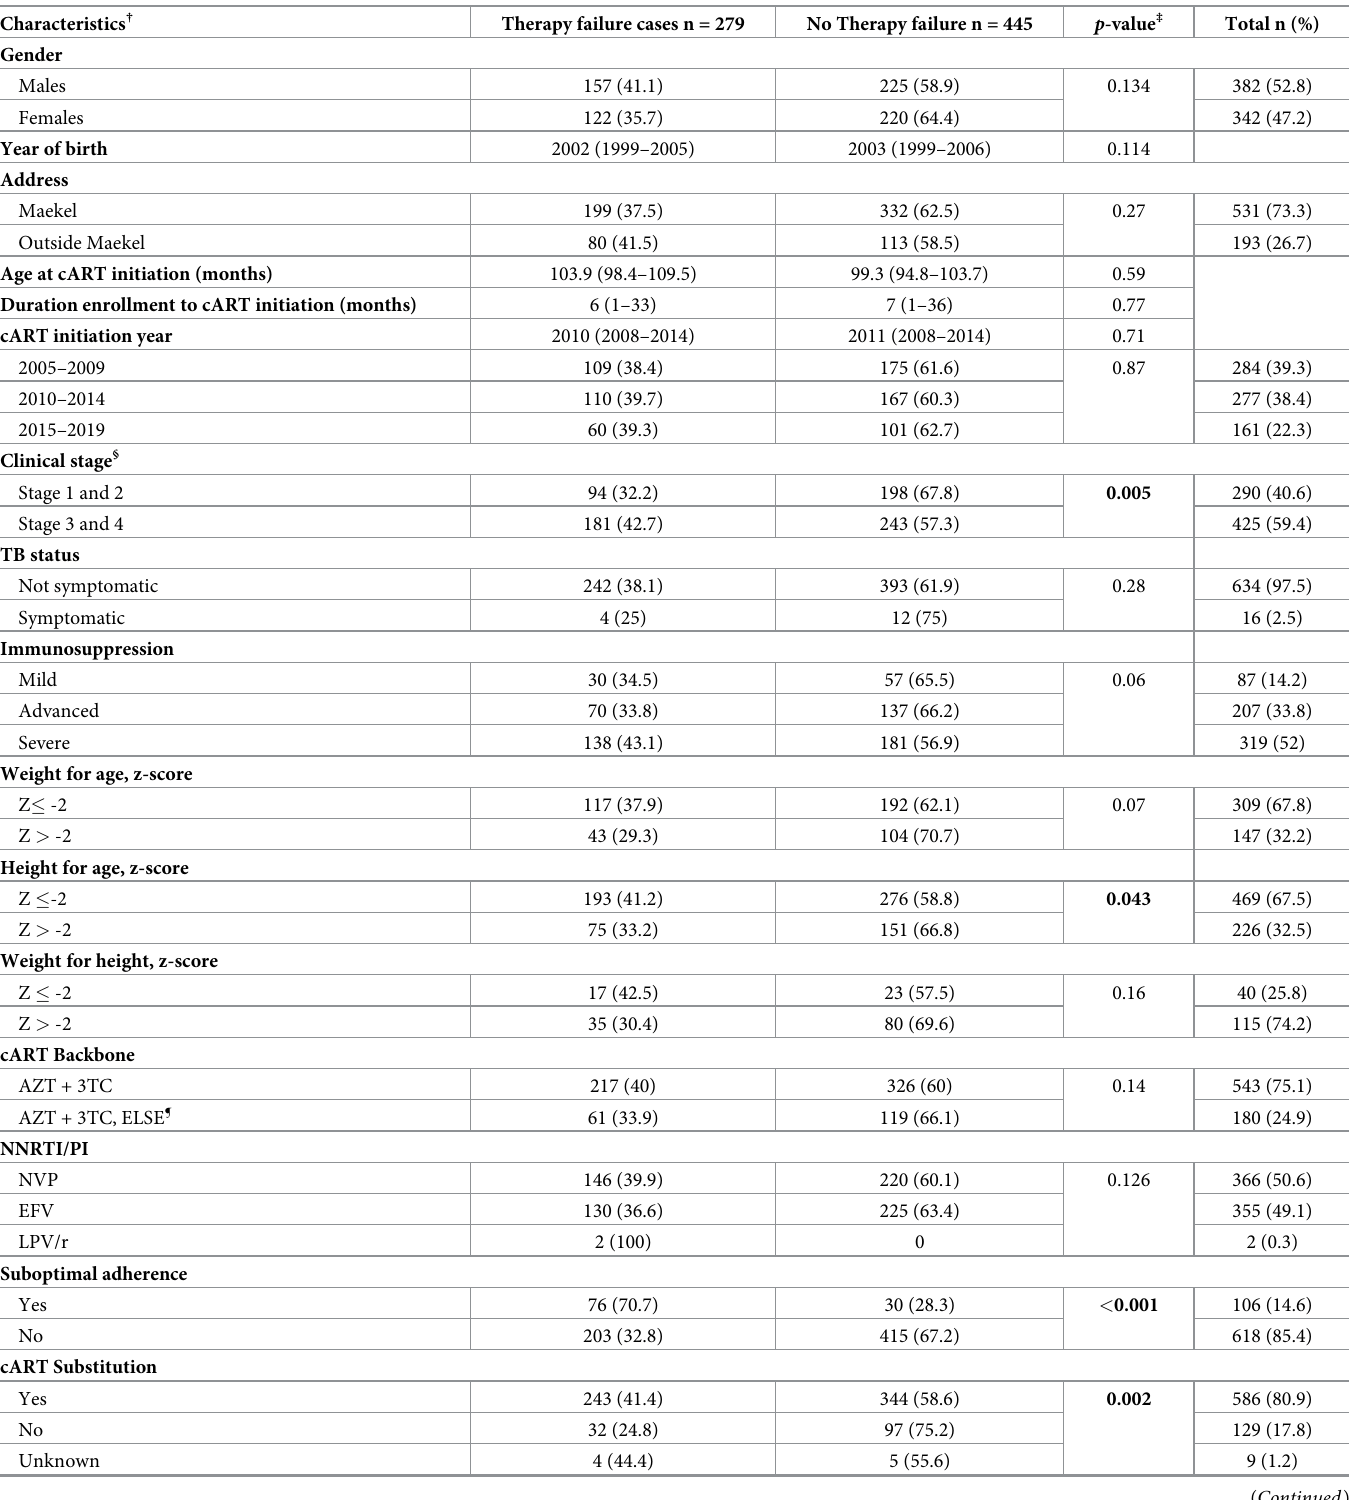
Table 3. Characteristics of the study participants stratified by therapy outcome in National Referral Pediatric Follow-up Clinic, Asmara, Eritrea